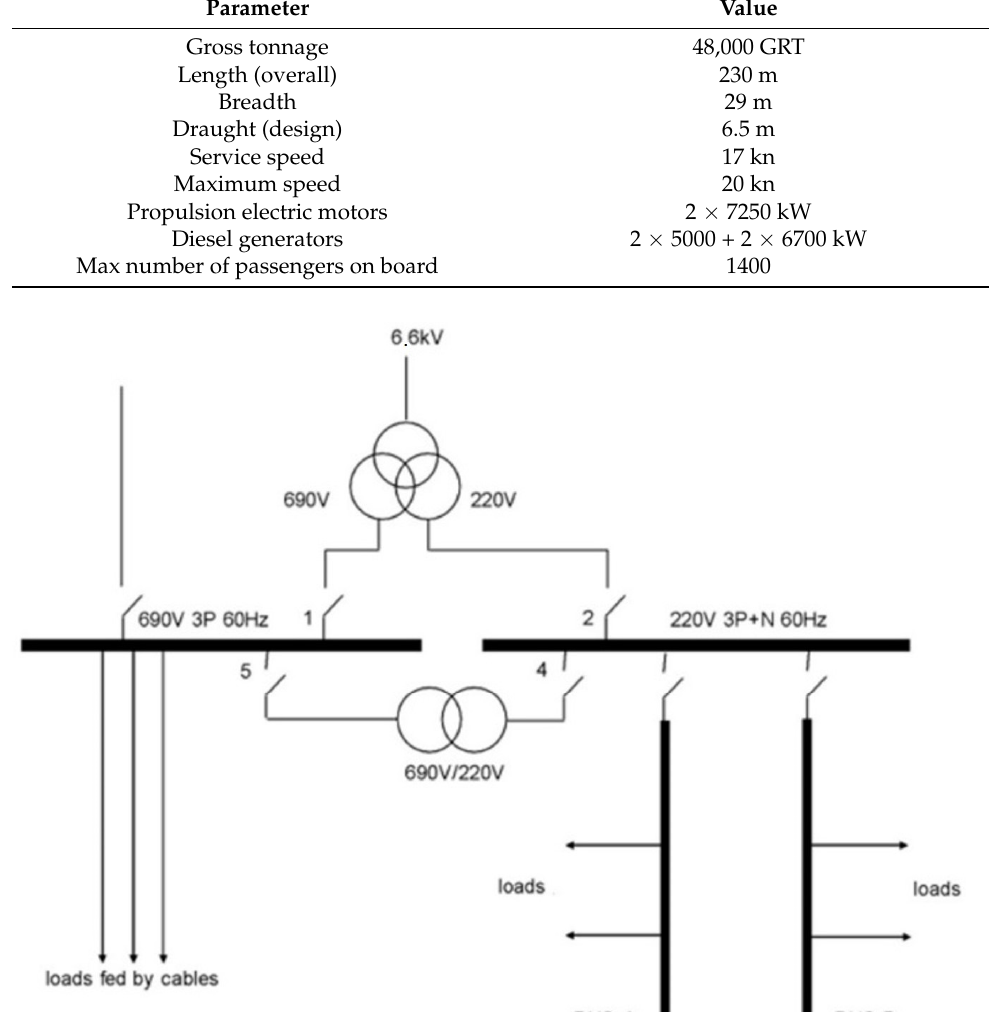
Table 1. Features of the cruise ship under study .